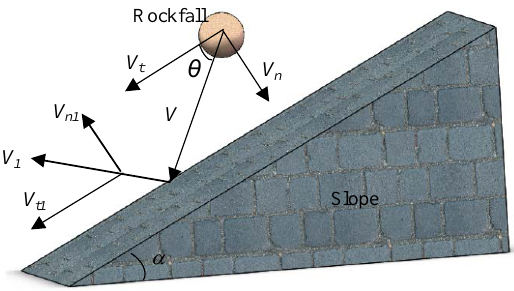
Figure 1. Motion model of